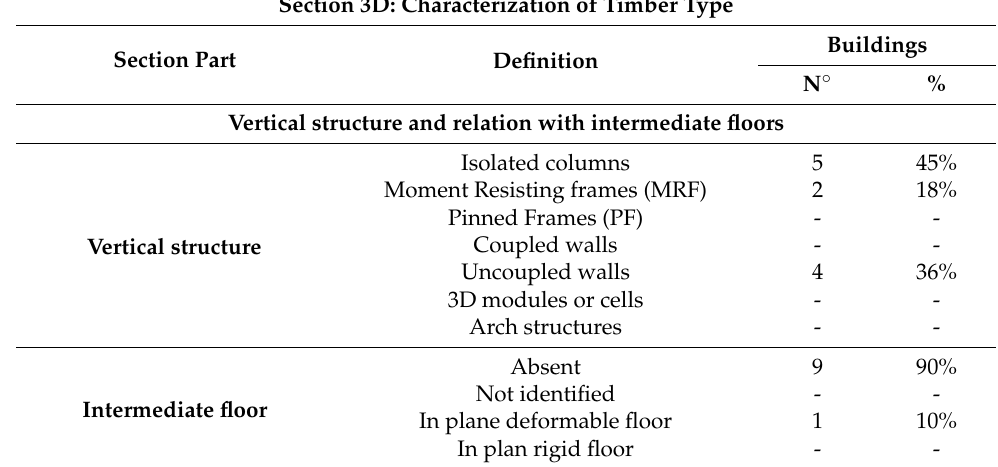
Table 13. 3D CARTIS-Building section. Case studies characterization: Characterization of timber type—Synoptic